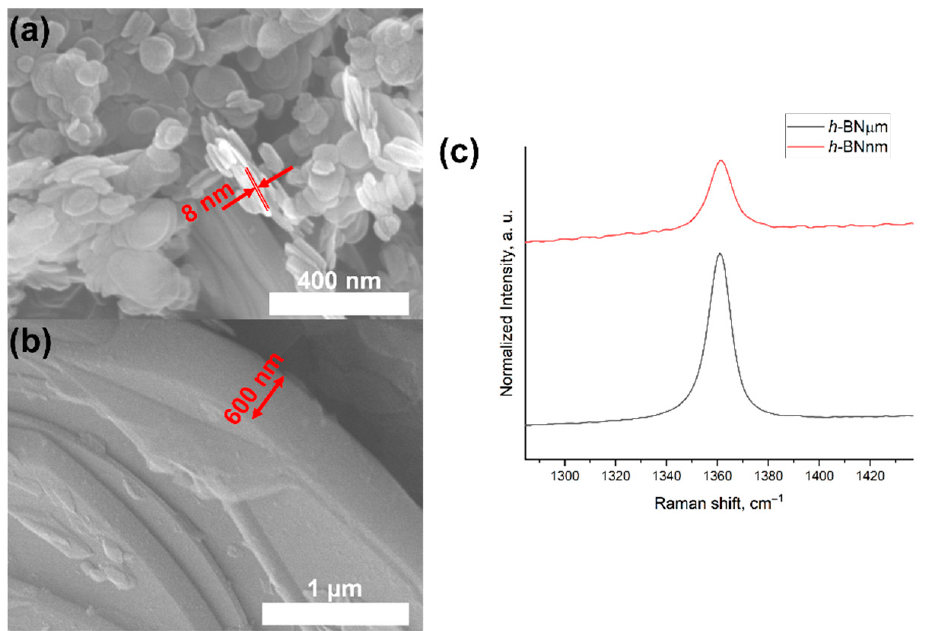
Figure 6. SEM images of h -BNnm ( a ), h -BNµm ( b ) and their Raman spectra ( c ).